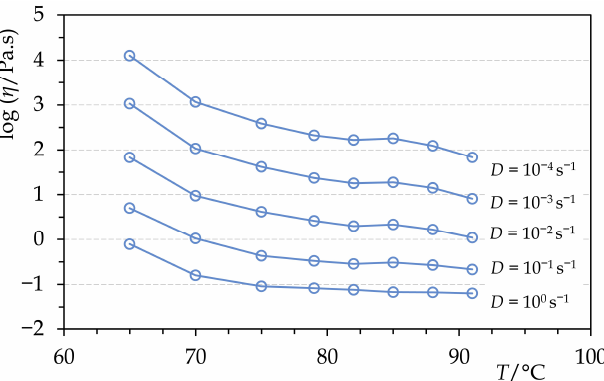
Figure 5. Temperature dependence of dynamic viscosity of molten Permulgin 3274 (cooling curves).